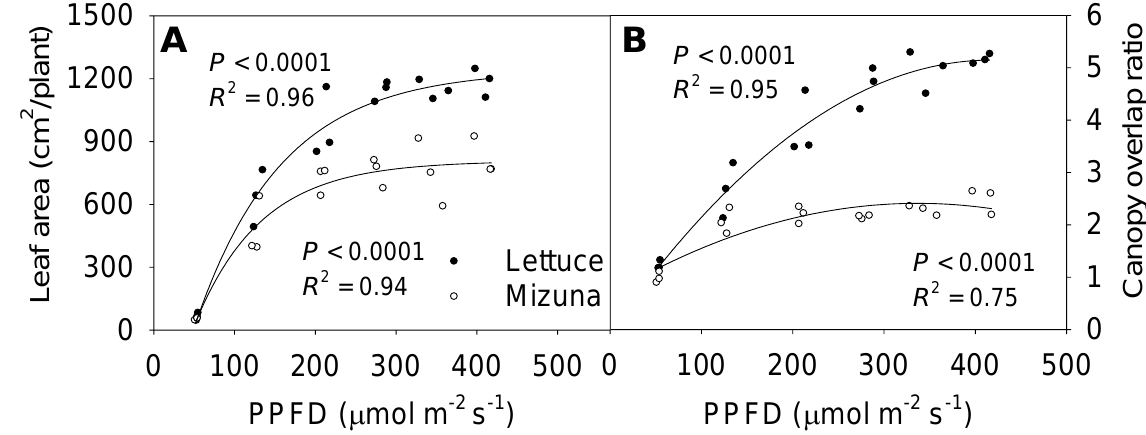
Figure 6. ( A ) Leaf area per plant and ( B ) canopy overlap ratio of mizuna ( Brassica rapa var. japonica ) and lettuce ( Lactuca sativa ‘Green Salad Bowl’) plants grown at six different photosynthetic photon flux densities (PPFD s ) for 27 and 28 days, respectively. The canopy overlap ratio is the ratio between the leaf area and the projected canopy size at harvest. Each data point represents the mean of nine plants.